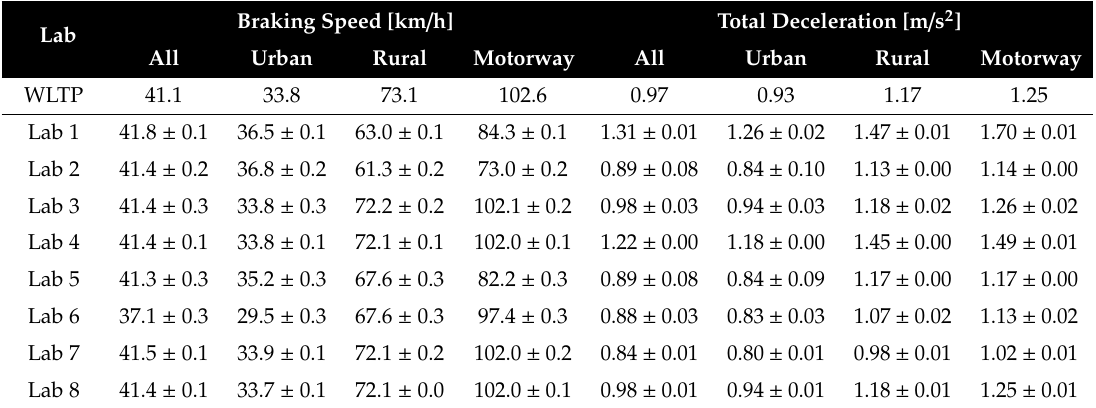
Table 2. Average and 95th percentile limits for braking speed and deceleration—data split into Total, Urban, Rural, and Motorway events. Braking Speed [km / h] Total Deceleration [m / s 2 ]